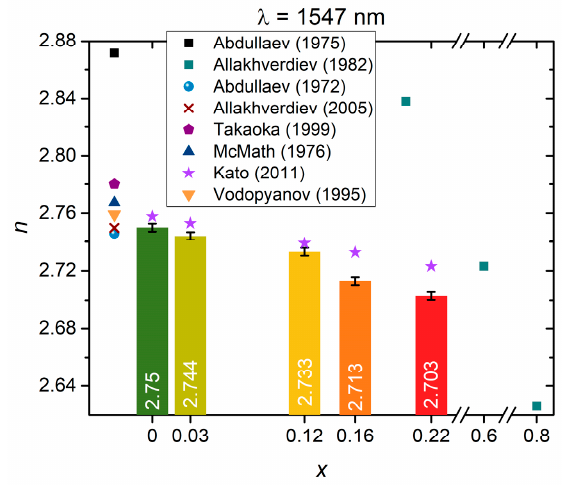
Figure 9. Ordinary refractive index of the GaSe:S crystals at λ = 1547 nm. Data, measured in this work, are presented in bars and compared with the results published in other works: Allakhverdiev (1982) [34], Allakhverdiev (2005) [39], Takaoka (1999) [40], Vodopyanov (1995) [41], Abdullaev (1975) [42], Kato (2011) [56], Abdullaev (1972) [64], McMath (1976) [65]. Some data for undoped GaSe is shifted horizontally for better readability.